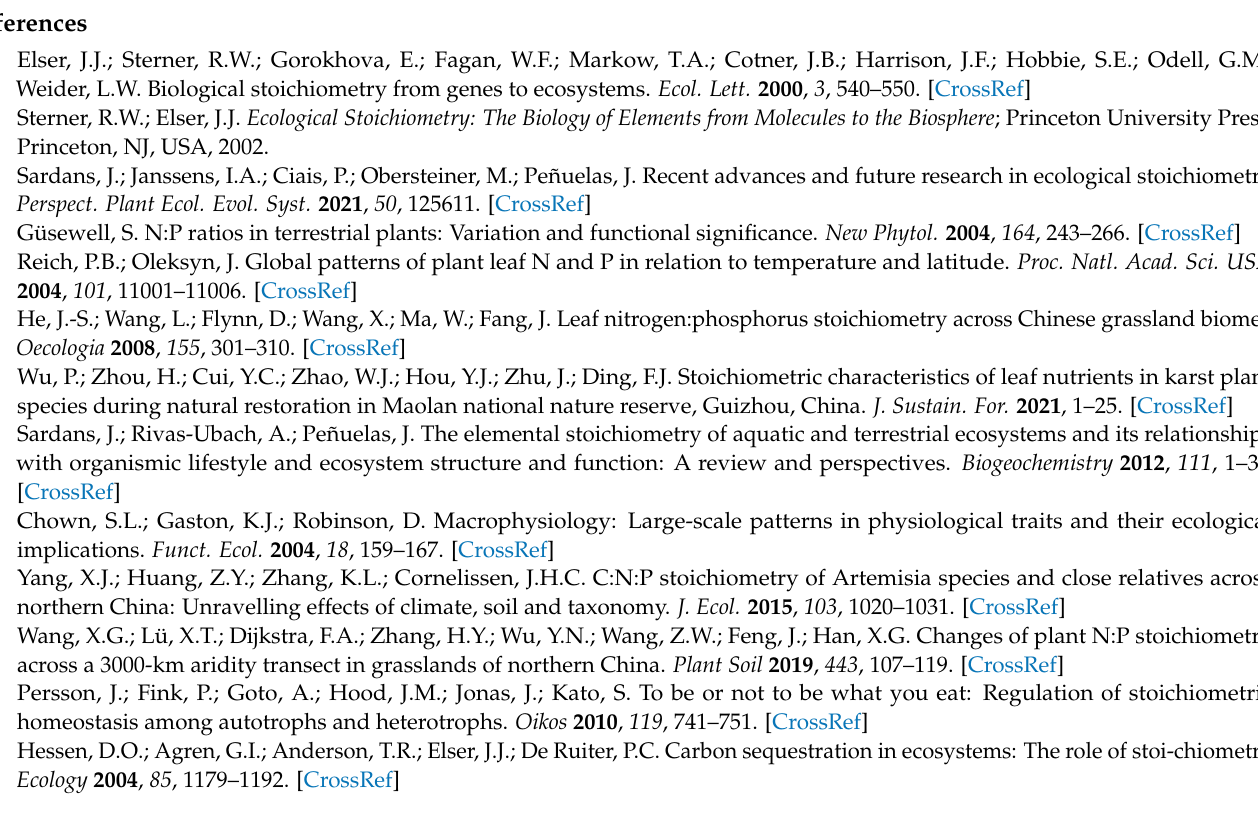
Figure S1: Heat map of Pearson correlations among S. chamaejasme leaf P content, soil P and AP content, soil water content (SWC), mean annual precipitation (MAP), and altitude (ALT) in IM region; Figure S2: Biplot for the first two axes of soil physicochemical